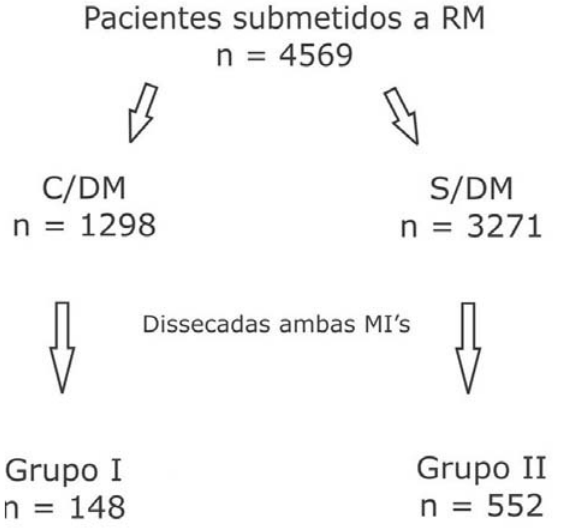
Fig. 1. Detalhamento da amostra. RM - revascularização do miocárdio, C/DM - diabético, S/DM - não diabético, ATIs - mamárias internas